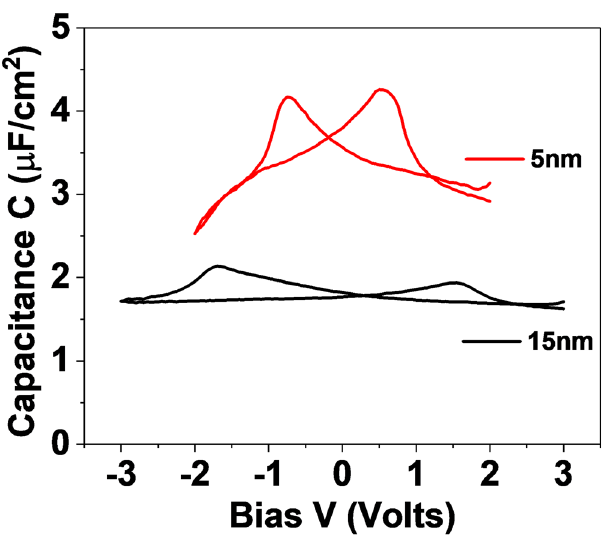
Fig. 3 Capacitance comparison of thin and thick Hf 0.5 Zr 0.5 O 2 fi lms. ac Capacitance ( C ) -Voltage ( V ) curves of 15 nm and 5 nm thick fi lms at a frequency of 1 KHz.